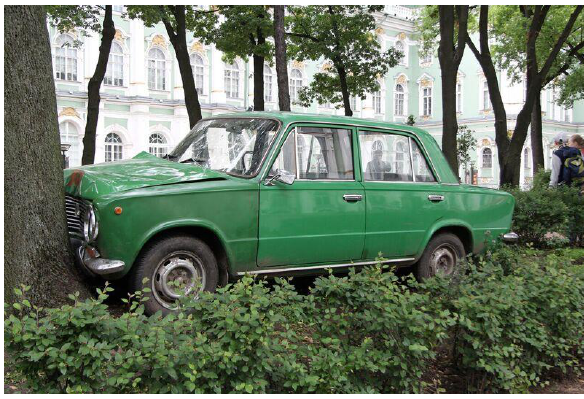
Figure 3 | Louise Bourgeois, Installation view, MANIFESTA 10, Winter Palace, State Hermitage Museum, showing The Institute (center), Collection of The Easton Foundation, New York, USA and Nature Study (right), Collection of The State Hermitage Museum,